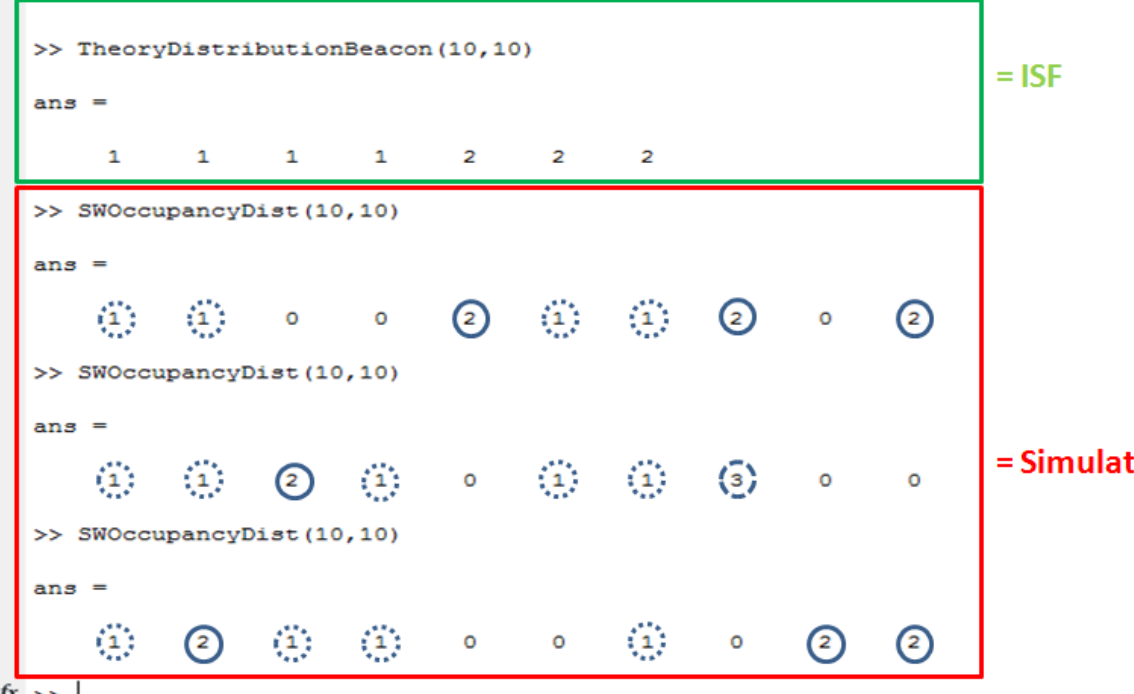
Figure 10. Comparison between the theoretical distribution of beacons using the ISF function and the simulated distribution where (NB, SW)=(10,10).